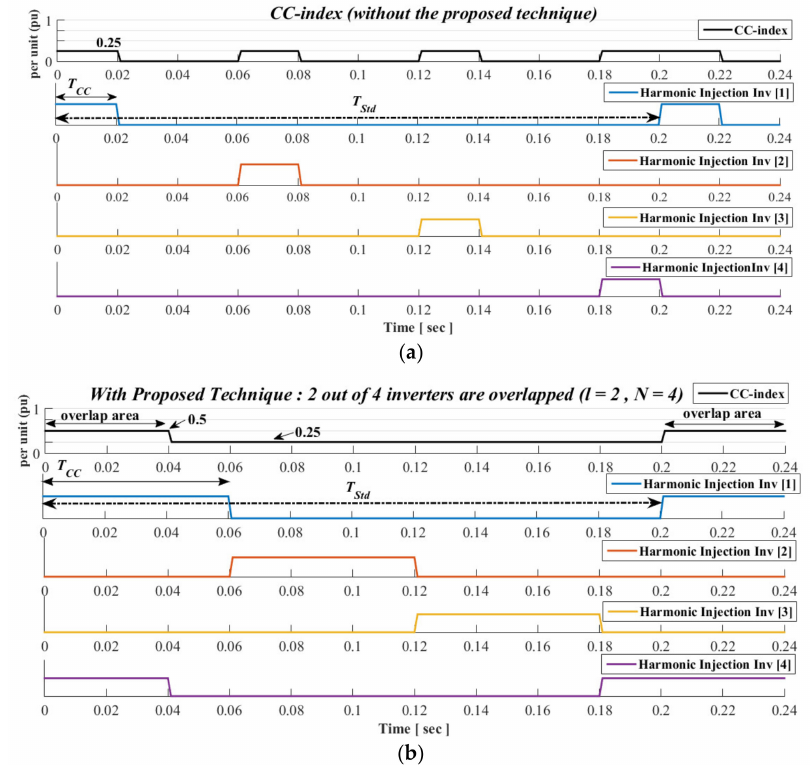
Figure 5. Injection pattern of the N-subgroup inverters and CC index evolution in a time domain for, ( a ) N = 4 and l = 1, ( b ) N = 4 and l = 2 (implying that at least two inverters will be